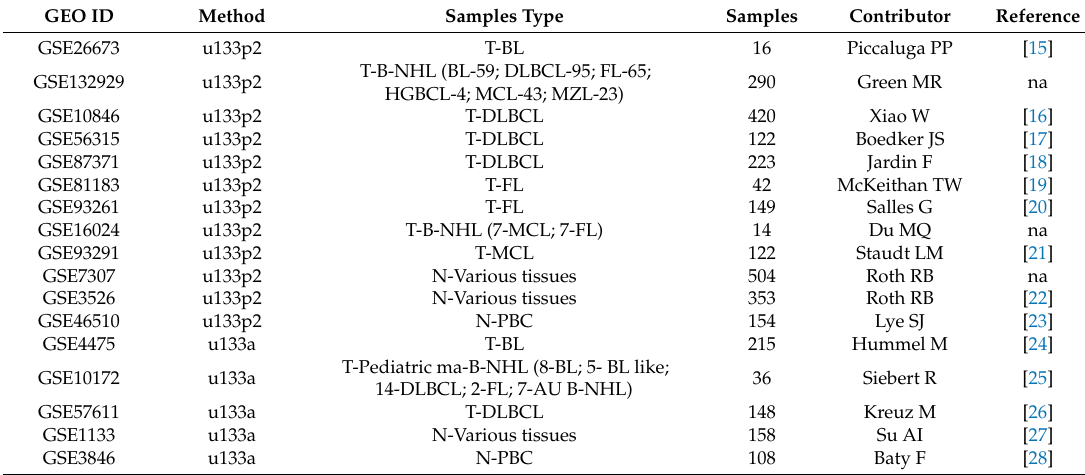
Table 2. Features of the GEO Datasets (Data normalization used: MAS5.0).